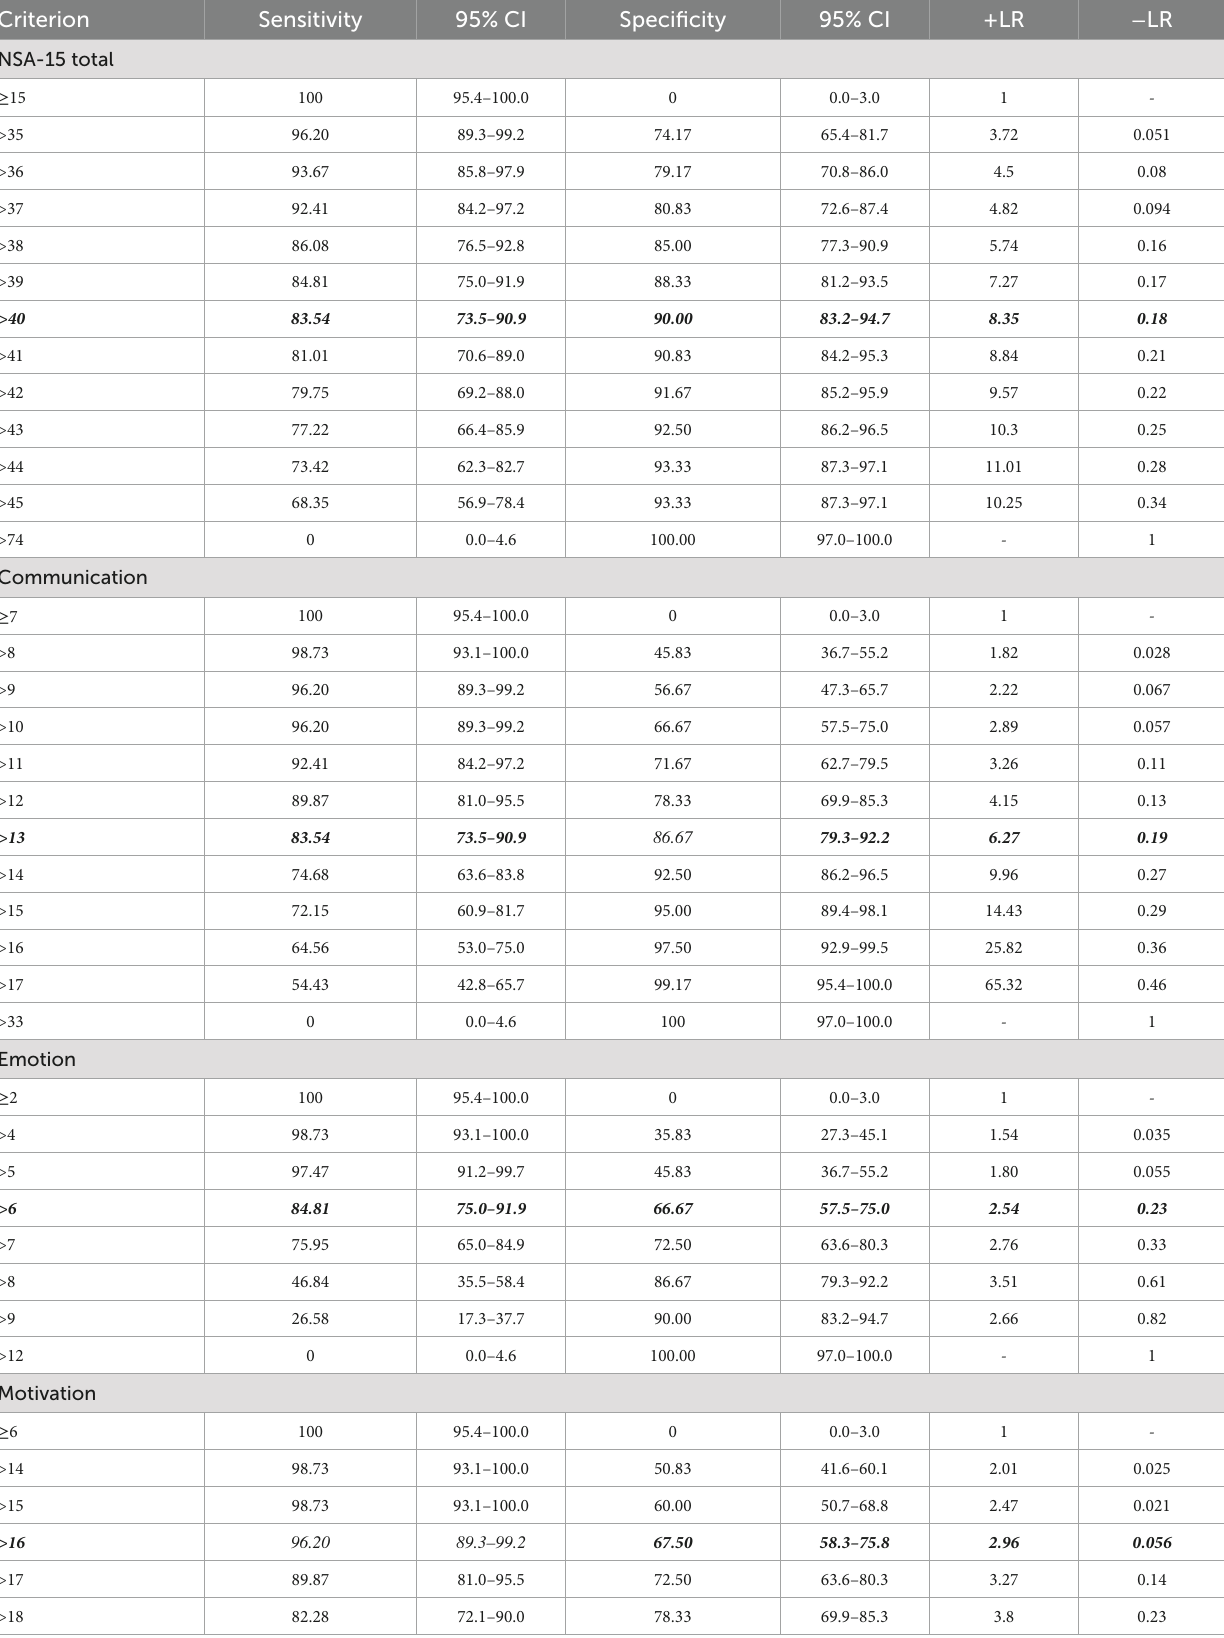
TABLE 2 The cutoff scores and corresponding sensitivity and specificity of the negative symptom assessment (NSA-15).